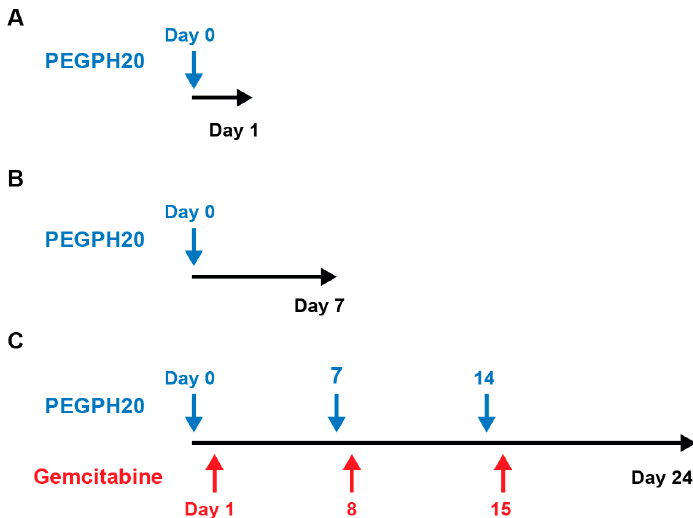
Figure 5. Study timeline. Quantitative magnetic resonance imaging was performed at ( A ) baseline and at 24 hours post-PEGPH20 treatment for ( n = 5) animals, at ( B ) baseline, 24 hours, and at day 7, ( n = 3) and ( C ) after treatment with PEGPH20 and gemcitabine at baseline, 24 hours, and at the completion of one full treatment cycle at day 24 ( n = 3).